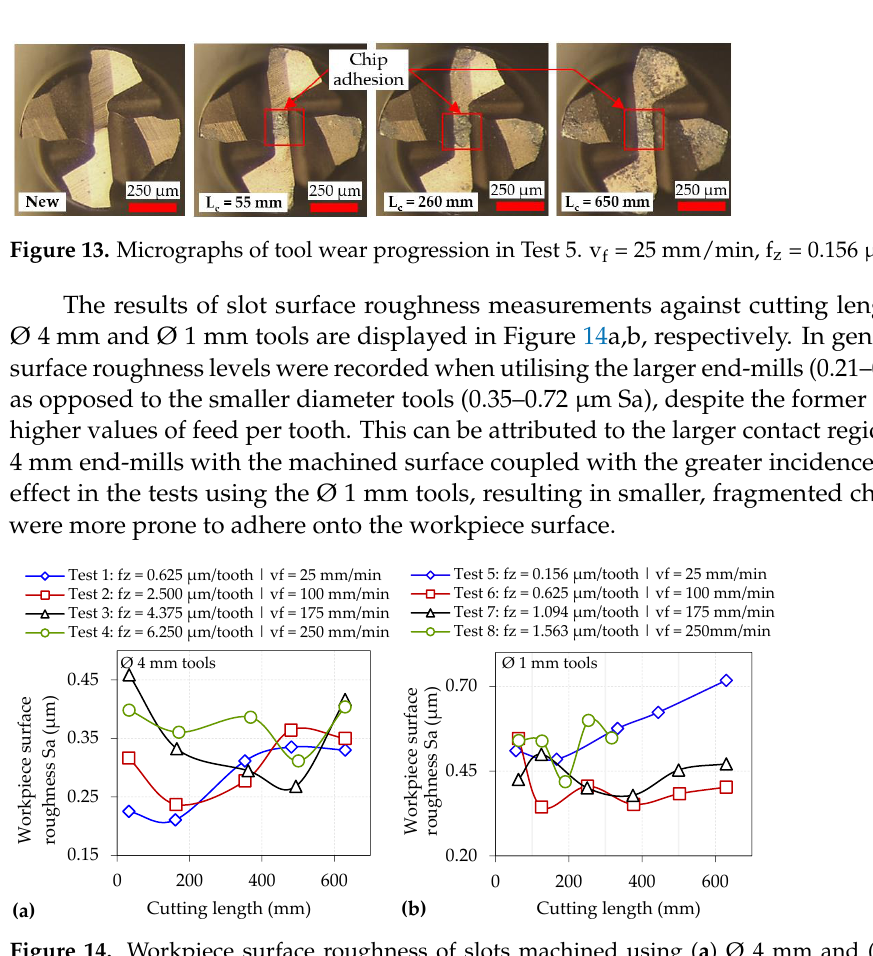
Figure 12. Micrographs and contour plots showing progression of material ploughing and depth of grooving for slots machined in Test 5. v f = 25 mm/min, f z = 0.156 µm/tooth.